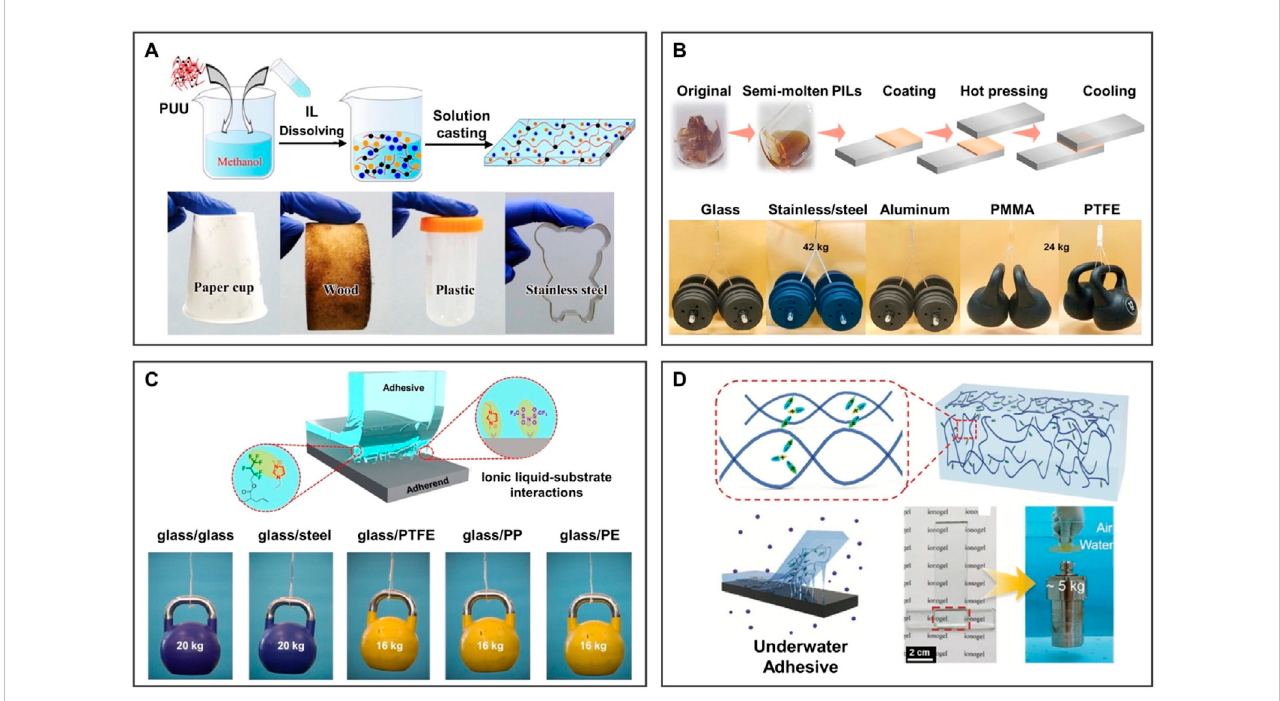
FIGURE 10 BILIMs for adhesive tape. (A) PUU polymer hydrogen bonding and amphiphilicity enable ionogels to adhere to any substrate, thus realizing the university of adherence to substrates. Reproduced with permission (Chen and Guo, 2021). Copyright 2021, American Chemical Society. (B) Flexible alkoxy chains are introduced into the cationic backbone of PILs, enabling strong hydrogen bonding and electrostatic interactions while contributing to high cohesive energy and interfacial adhesive energy to obtain high-ef fi ciency adhesive. Reproducedwith permission (Zhang et al., 2021).Copyright 2021, Wiley-VCH GmbH. (C) Ion-dipole interactions between P(HFBA- co -MMA) and hydrophobic ILs for higher adhesion strength and reversible adhesion. Reproduced with permission (Huang et al., 2021). Copyright 2021, American Chemical Society. (D) Ionogel soaked in the salt solution can discharge the salt ions on the surface of the substrate to adhere to the substrate, and the adhered substrate can lift a heavy object up to 5 kg, realizing reversible and strong adhesion. Reproduced with permission (Yu and Wu, 2021). Copyright 2021, Wiley-VCH